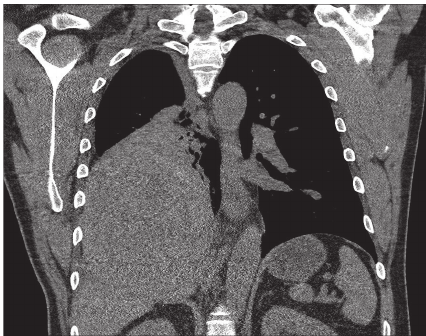
Figure 1: CT scan of the chest on presentation to hospital revealing very large (14 × 14 × 12cm) lung mass.